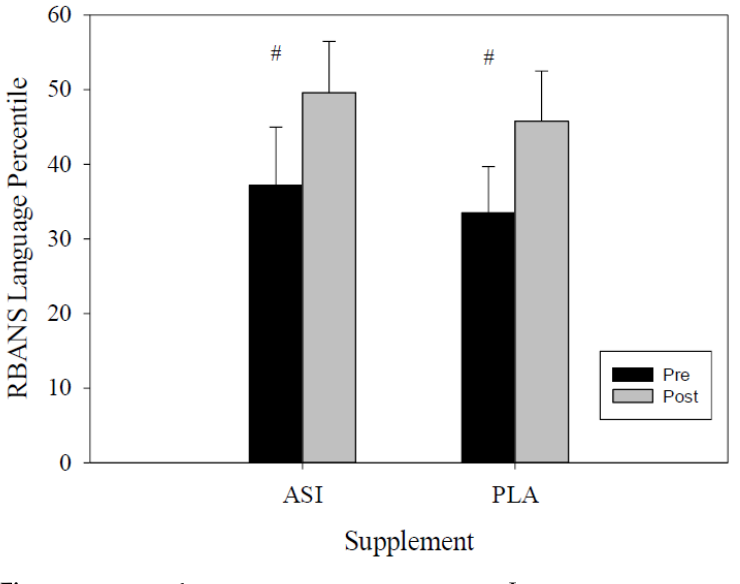
Figure 4. Language percentile score. #-indicates differences within-trial. The delayed memory percentile scores were examined through RMANOVA. Signif- icant within-trial differences were found ( F (1, 27) = 19.119, p < 0.001; η 2 p = 0.42; Figure 5). No significant between-trial differences were found between supplement trials ( F (1, 30) = 2.109, p = 0.15; η 2 p = 0.06; Table 1).